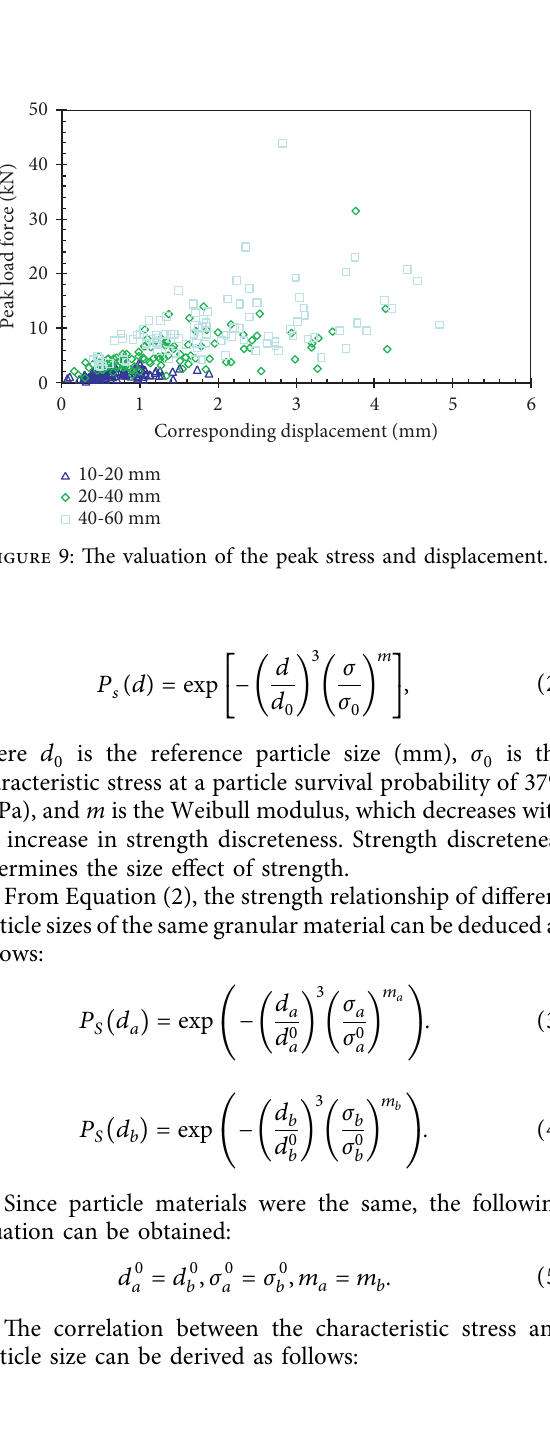
Figure 8: Typical force-displacement curve.